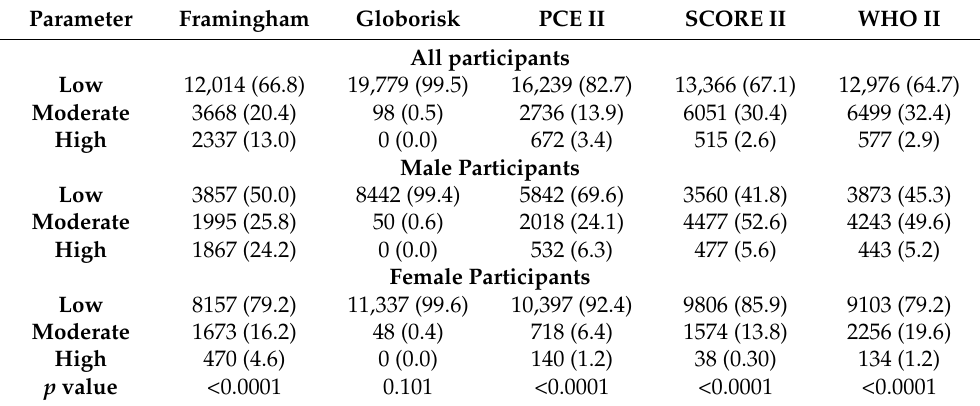
Table 2. CVD Risk classification among multi-ethnic population living in the Netherlands using laboratory-based Cardiovascular risk